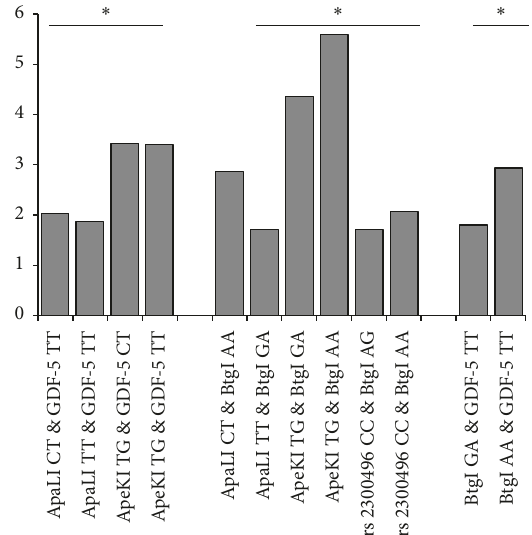
Figure 1: Risk associated with GDF-5, ESR- 𝛼 , and CALM-1 geno- type combinations in knee OA. Figure contains only significant OR of genotype combination of various candidate gene in knee OA. ∗ 𝑝 < 0.05 is considered statistically significant.